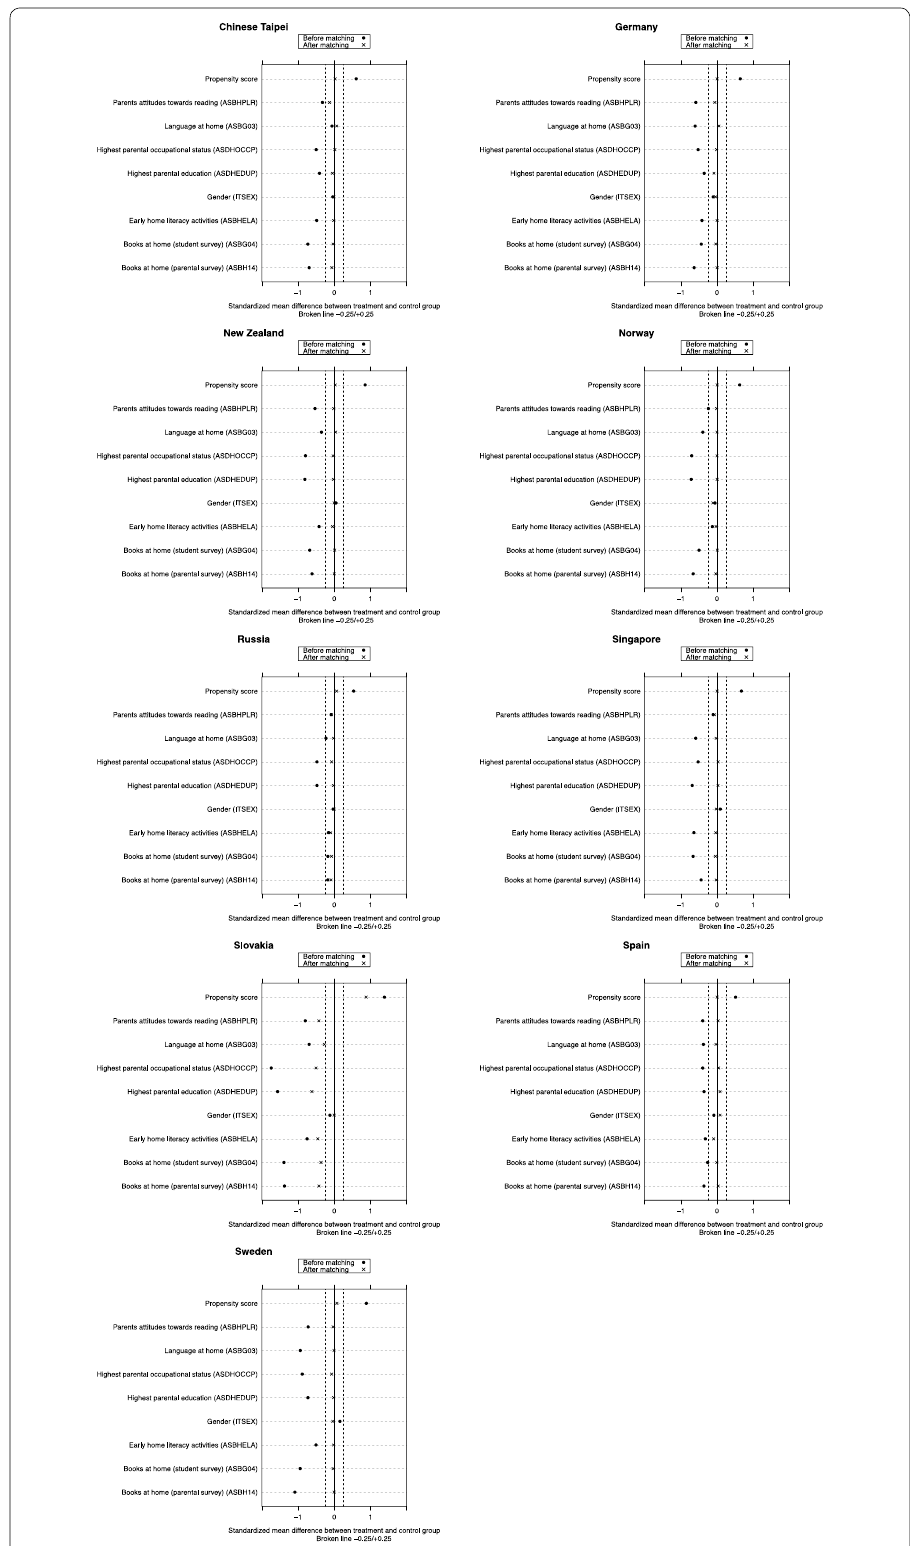
Fig. 1 Standardizes bias pre- and post-match